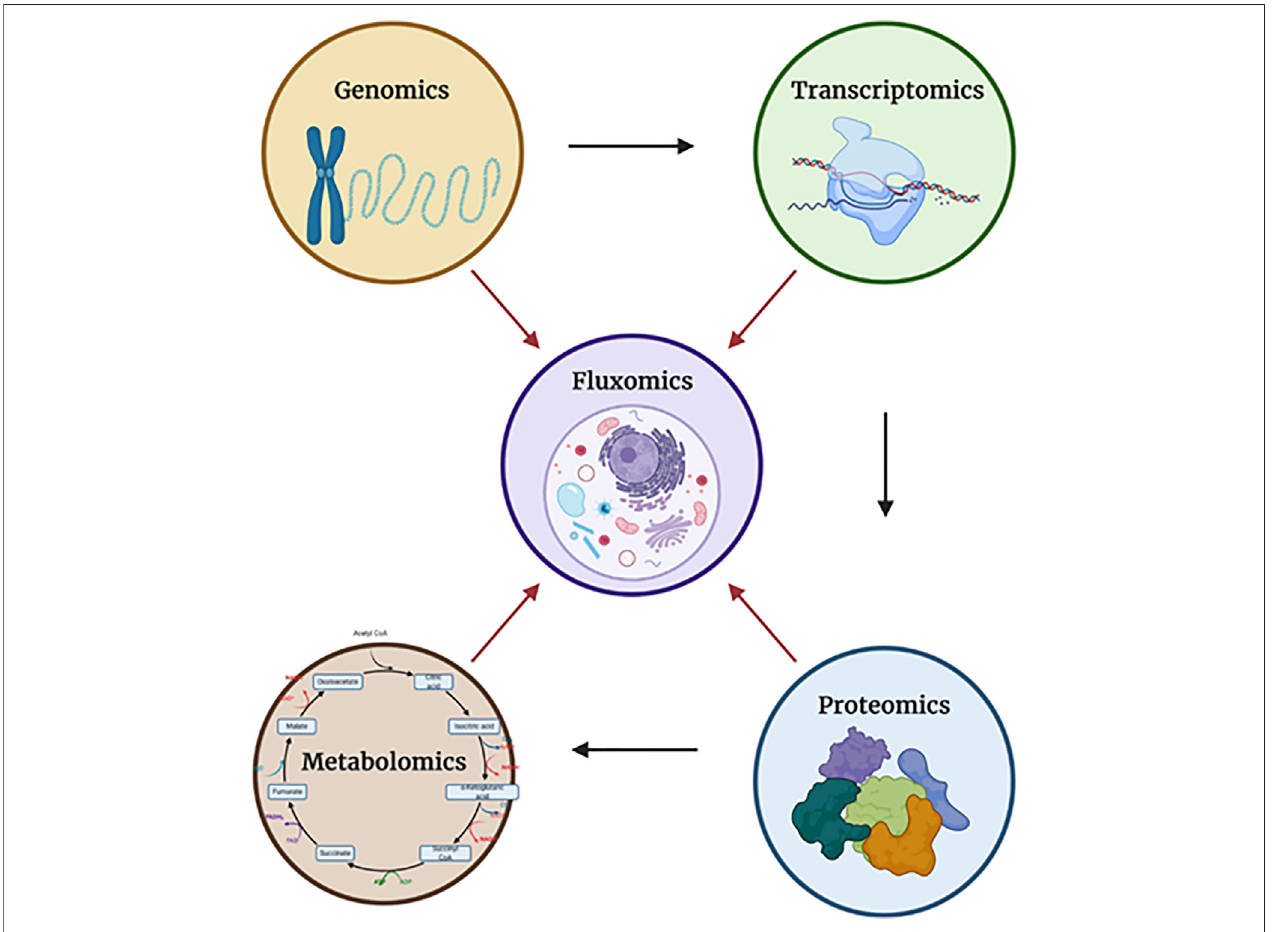
FIGURE 2 | The relationships between each ofthe “ -omics ” . Each of the arrows shows the direction in which a particular “ -omic ” in fl uences another. In the case of fl uxomics,itcombinesallapproaches,grantingbetterunderstanding.Daunerdescribesobserved fl ux/activityasatwocomponent-capacity-basedandkinetics-based - regulation ( Figure 3 ). Created with